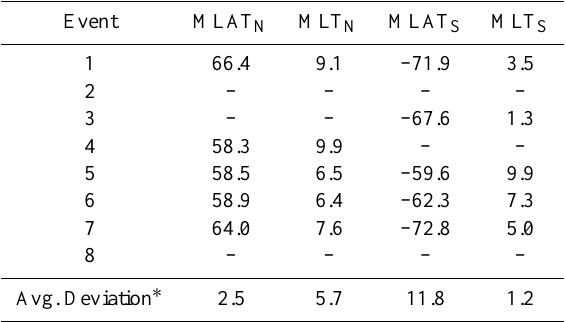
Table 3. Average ionospheric footprint locations in magnetic lati- tude and local time (UT) coordinates. The subindices refer to the mapped field line locations ending in the northern (N) or southern (S)